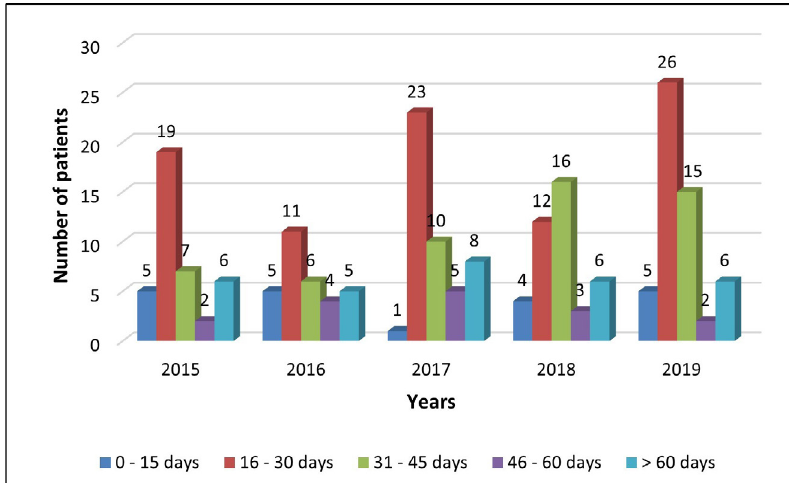
Figure 6. Age of onset of treatment for infants diagnosed with CH.